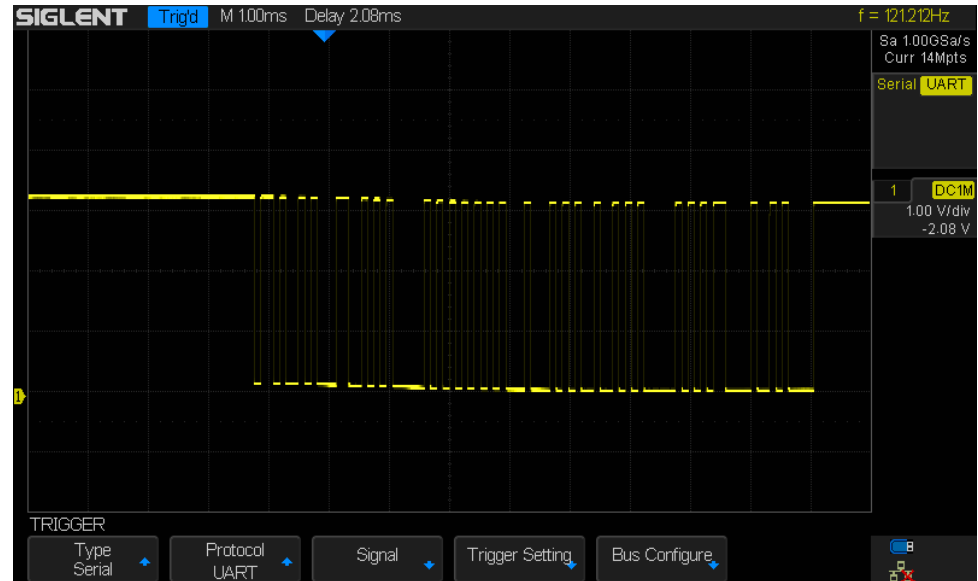
Figure 16. Sending “KLAUDIA”—one more time, verifying Bluetooth transmission, with a longer